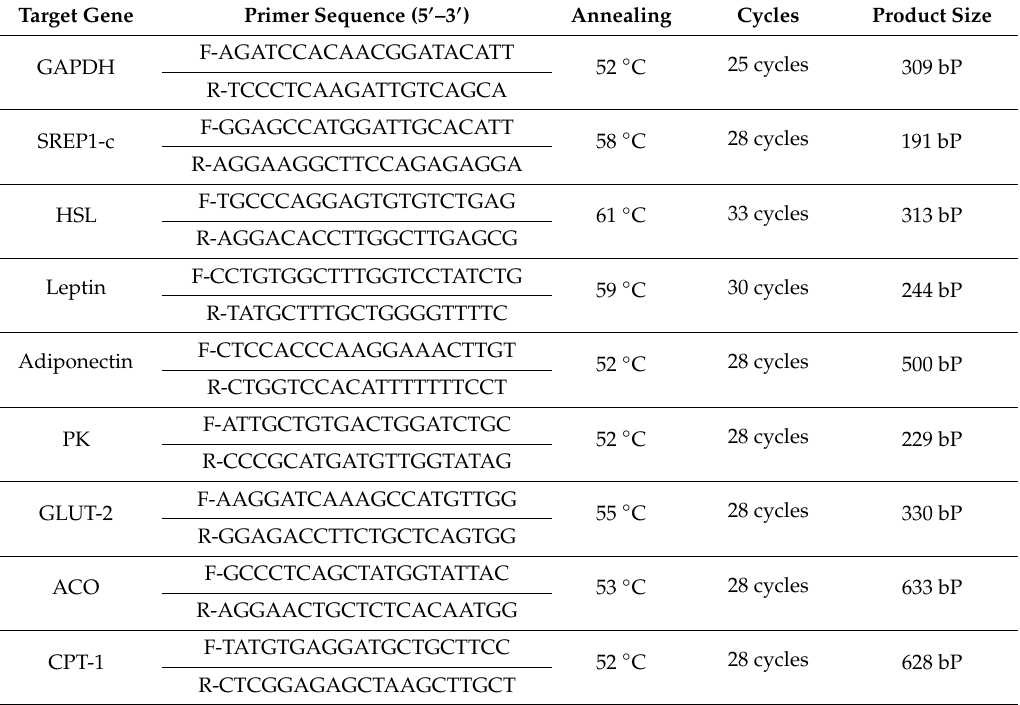
Table 1. Primer sequence and PCR conditions used in this